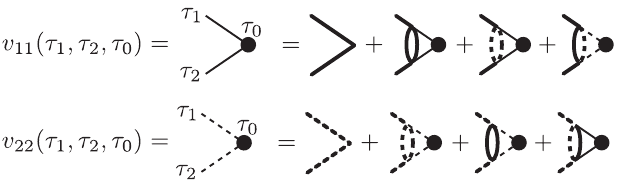
FIG. 6. The Bethe-Salpeter equations for the three-point func- tions v 11 and v 22